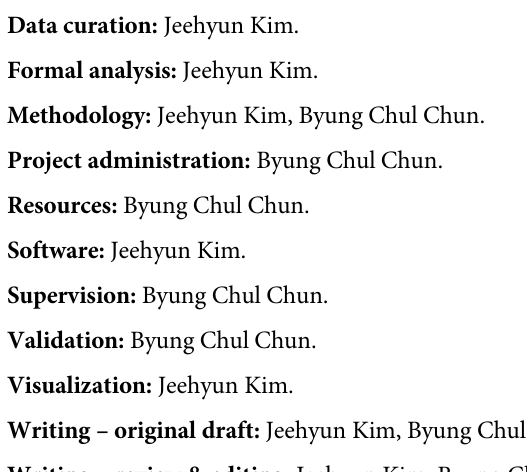
S1 Table. Distribution of covariates by pet-ownership before and after